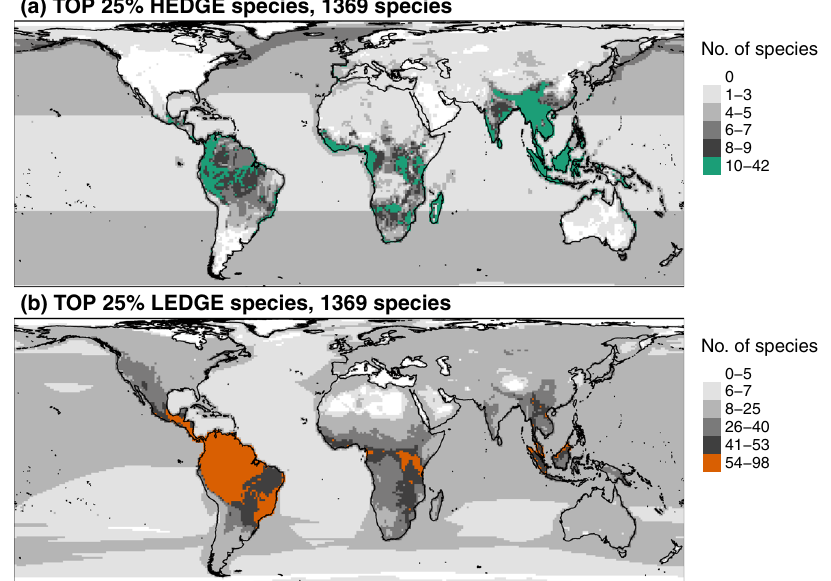
Fig. 3 Spatial patterns and hotspots of species richness of the species of interest for conserving global mammalian PD. Spatial patterns and hotspots of species richness for the TOP 25% HEDGE species ( a ) and the TOP 25% LEDGE species ( b ). Hotspots, in colour, represent the 2.5% richest cells.